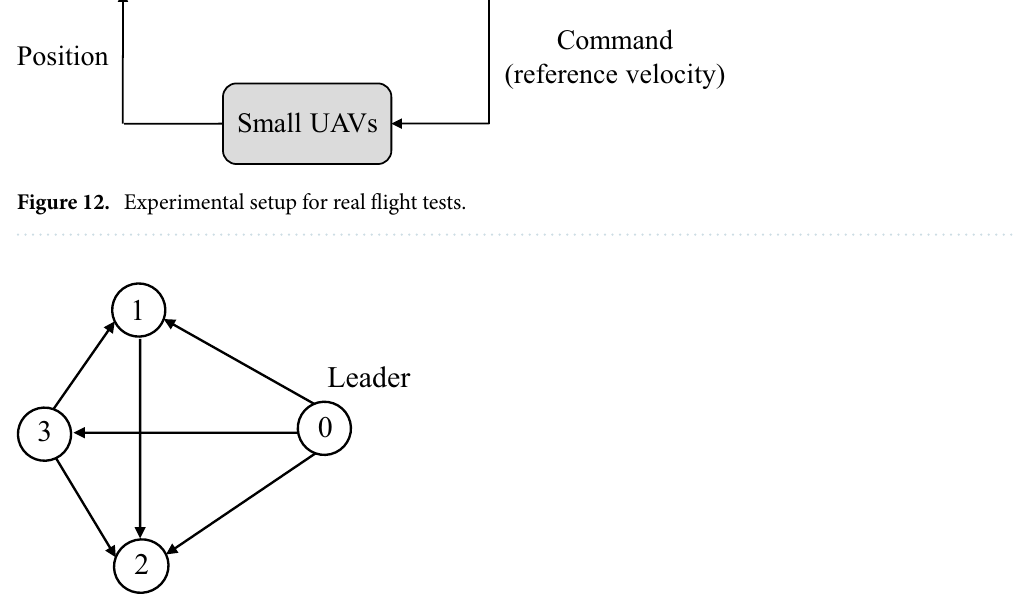
Figure 13. Communication network in the